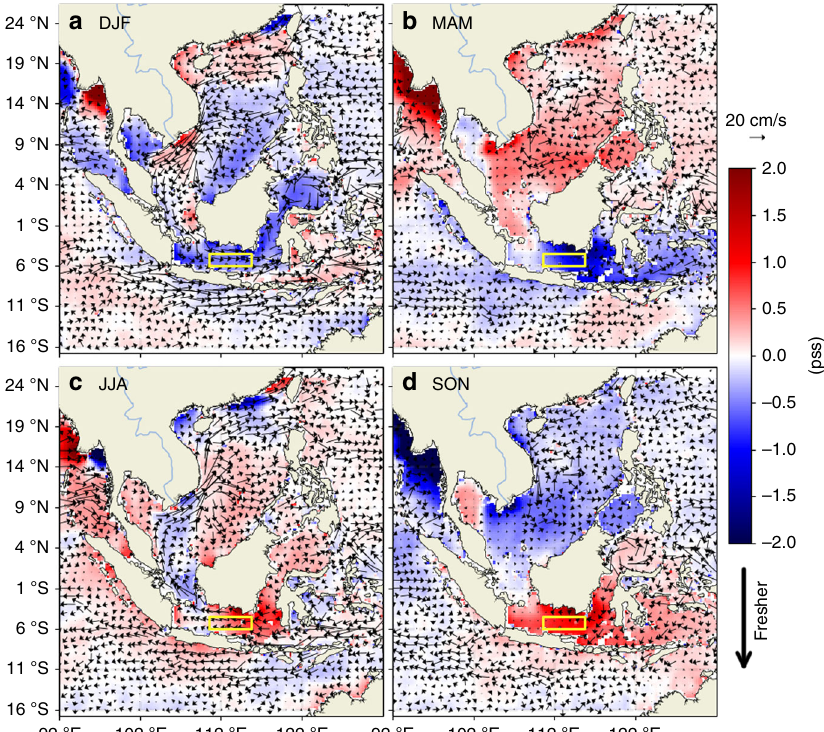
Fig. 3 Composite seasonal maps of sea surface salinity anomalies from the SMAP satellite with ocean surface currents superimposed. a – d correspond to the maps for the DJF, MAM, JJA, and SON seasons. To facilitate visual inspection, the current vectors are plotted every 1°. The yellow box (110.5 – 115.75 °E, 6 – 4.5 °S) indicates the region where the sea surface salinity budget analysis was performed (results shown in Figs. 7, 8)